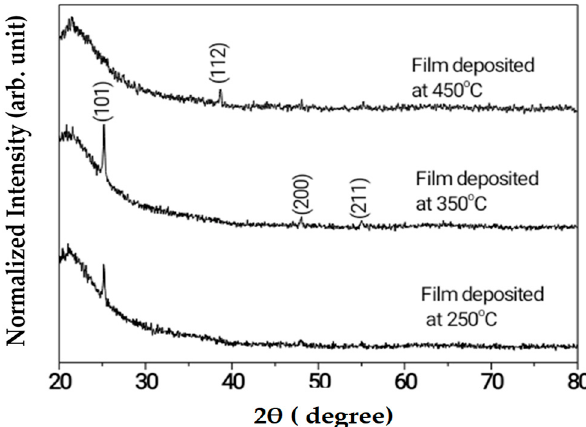
Figure 1. XRD patterns of the as-deposited films.